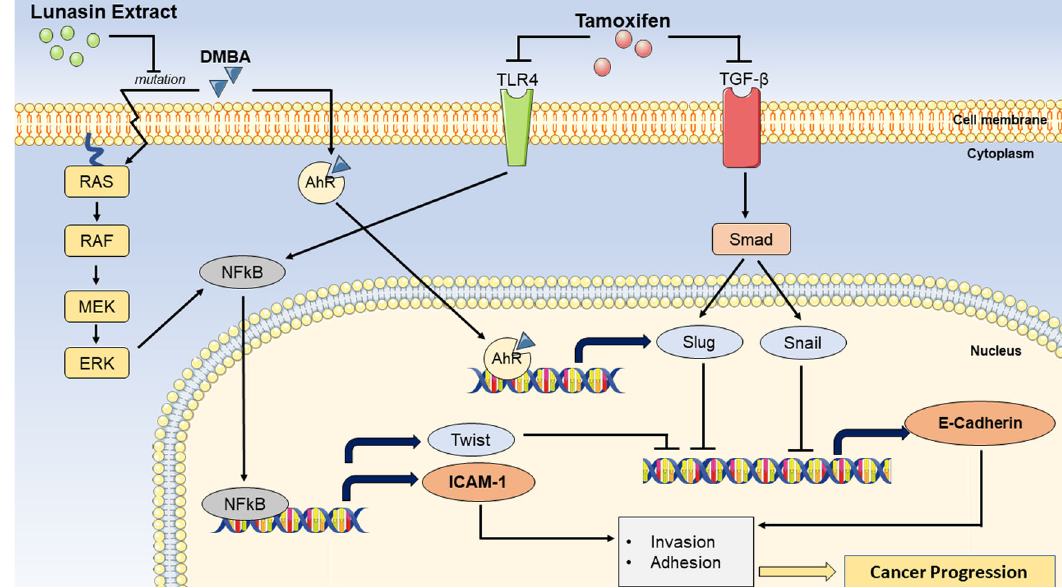
Figure 5. Schematic molecular pathway of LE regarding ICAM-1 dan E-Cadherin expression. 7,12-Dimethylbenz [a] anthracene (DMBA) can cause breast cancer by inducing Ras mutations, which cause nuclear factor-kappaB (NFkB) potentiation via the Ras-RAF-MEK-ERK pathway. ICAM-1 and TWIST expression will be enhanced as a result of NFkBactivation. TWISTisatranscriptionfactorthatinhibitstheproduction ofE-Cadherin.DMBAcanalso bindtoaryl hydrocarbon receptor (AhR) and promote the transcription of Slug, an inhibitor of E-Cadherin production. Lunasin